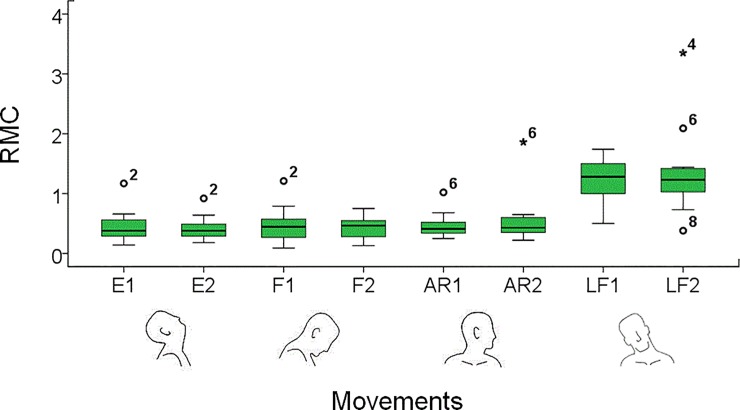
Ratio of movement coupling (RMC) values measured in movements executed by ALS patients reaching the maximum amplitude.Movements performed: Extension (E), Flexion (F), Axial Rotation (AR) and Lateral Flexion (LF). 1: movement from neutral position; 2: movement back to neutral position. Values are presented through the median, upper and lower quartiles and upper and lower extremes. Outliers and extreme outliers are represented by circles and stars, respectively. Numbers above the outliers indicate the patient associated to that value, consistently with Table 4.